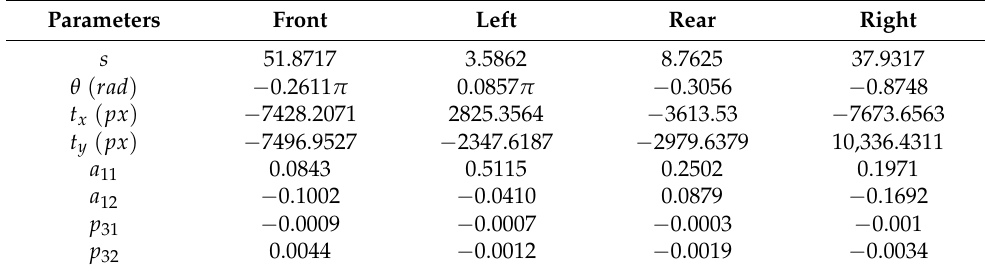
Table 1. Estimated image transformation